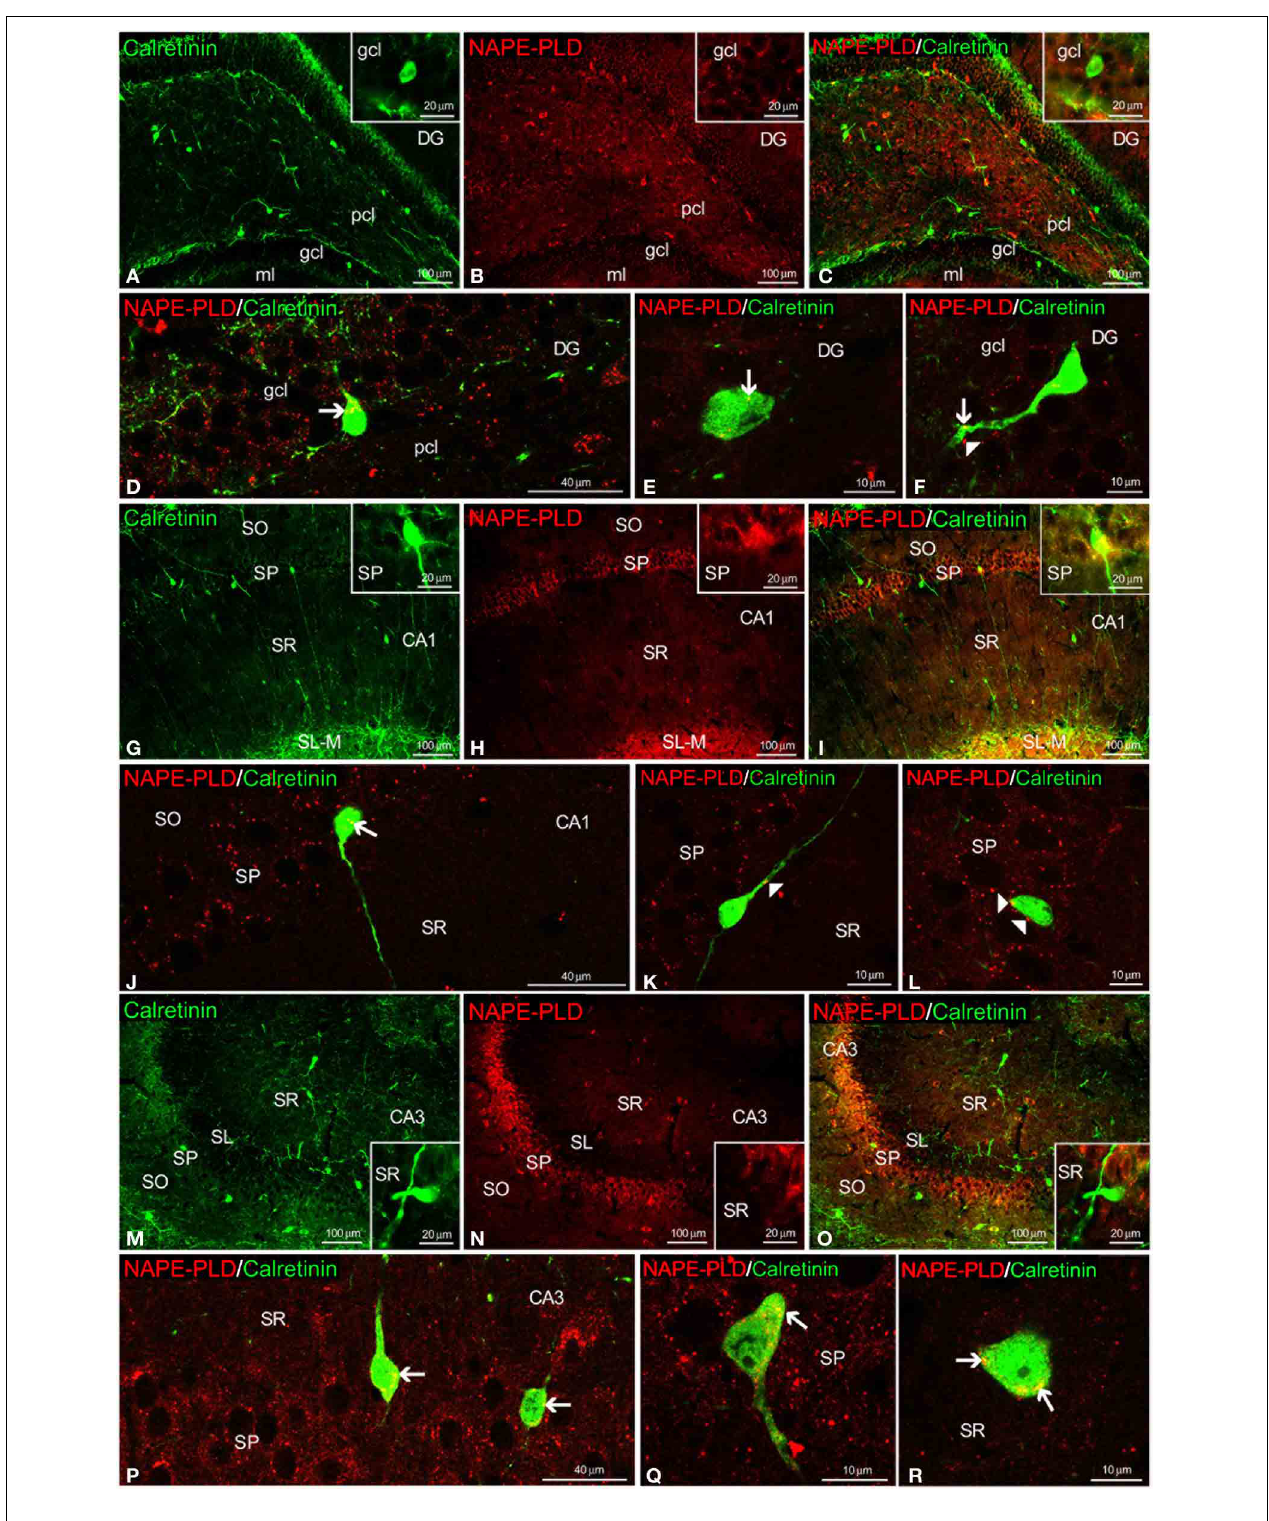
FIGURE 7 | NAPE-PLD and calretinin co-expression in the rat hippocampus. Low-resolution epifluorescence photomicrographs (A–C,G–I,M–O) and high-resolution confocal laser scanning photomicrographs (D–F,J–L,P–R) showing the labeling of calretinin (green) and NAPE-PLD (red) in the dentate gyrus (DG), CA1,